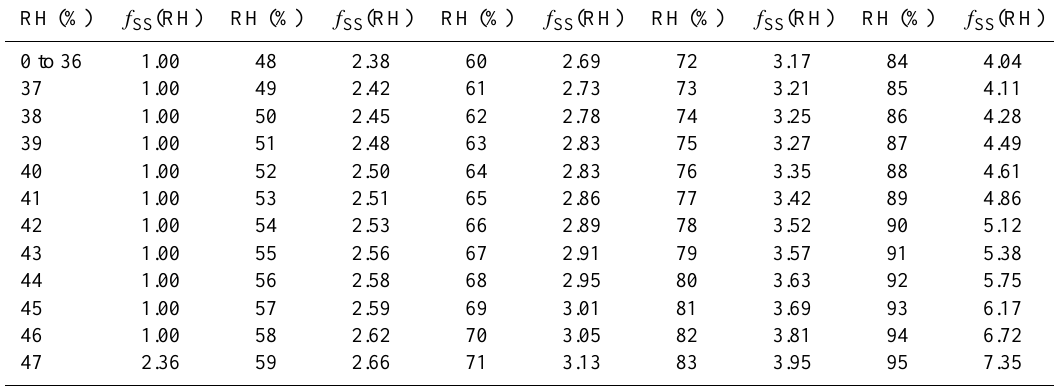
Table 4. Hygroscopic growth factors for sea-salt